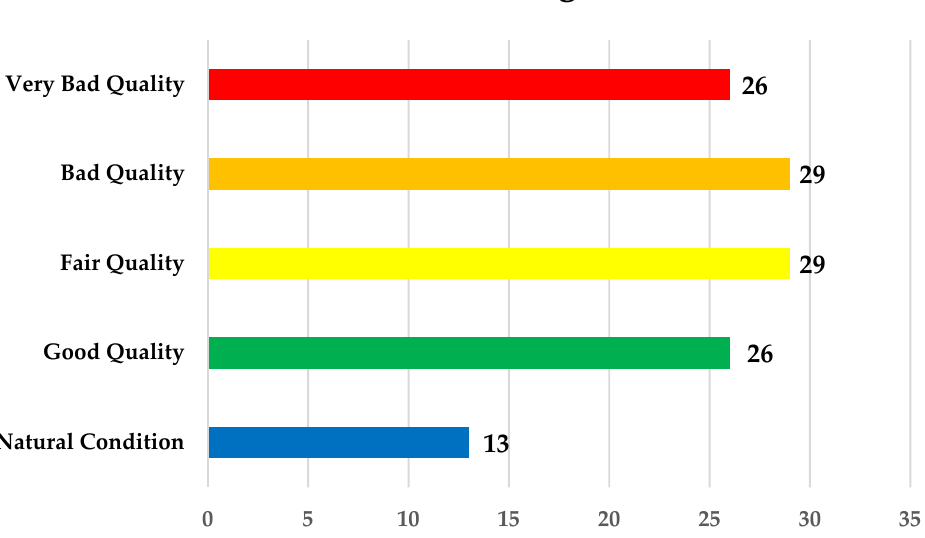
Figure 3. Number of sites per class according to QBR Index.